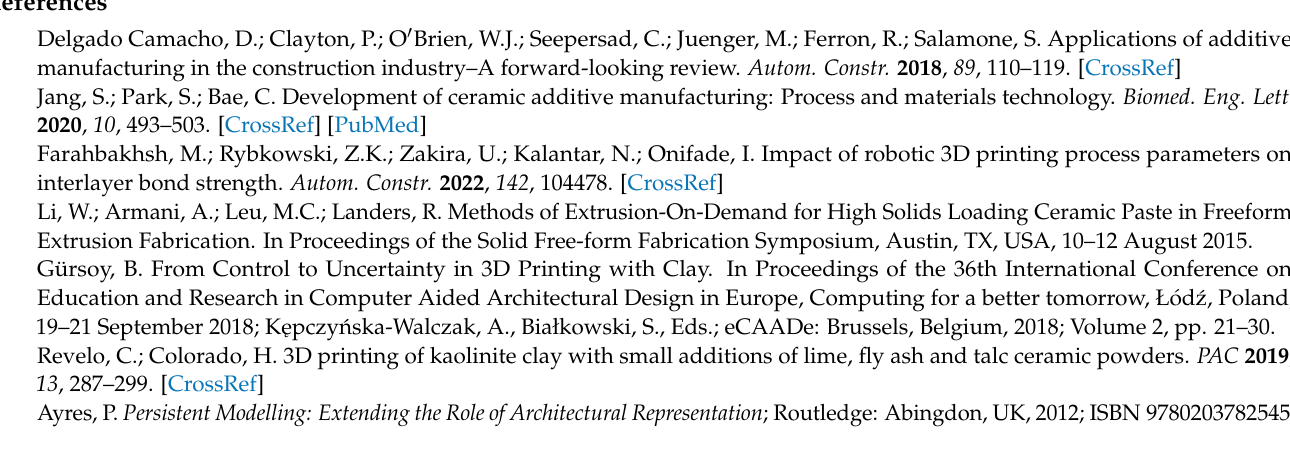
Figure 2a—Preliminary tests for the selection of the digital model: (a) straight wall with a 1 mm material thickness; Video S2: Clip of Figure 2b—Preliminary tests for the selection of the digital model: (b) curved wall with a 1 mm material thickness; Video S3: Clip of Figure 2c—Preliminary tests for the selection of the digital model: (c) straight wall with about a 2 mm material thickness; Video S4: Clip of Figure 8b—Influence of electromagnets on test wall: (b) electromagnet activated unilaterally (left); Video S5: Clip of Figure 8c—Influence of electromagnets on test wall: (c) electromagnets activated bilaterally; Video S6: Clip of Figure 9a,b—Wall tilting: (a) starting position, (b) tilting the wall to the left; Video S7: Clip of Figure 10—Illustration of the wall deforming under the influence of the threaded iron rod in the electromagnet; Video S8: Clip of Figure 12—Deformation of the wall by a permanent magnet and pulsating movement (without laser sensor); Video S9: Clip of Figure 14—Deformation of the wall measured with a laser sensor: (a) starting position 12 mm away from the wall; (b) slow approach to 8 mm and stop in front of the wall; (c) short jump to 7 mm and pull back to